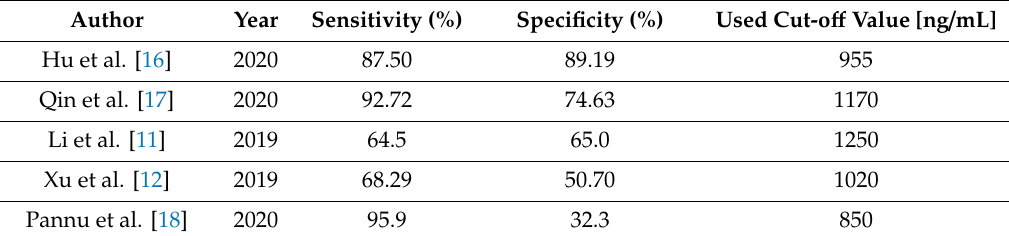
Table 3. Published results of serum D-dimer in diagnosing prosthetic joint infection (PJI) since its inclusion in the Musculoskeletal Infection Society (MSIS) criteria in